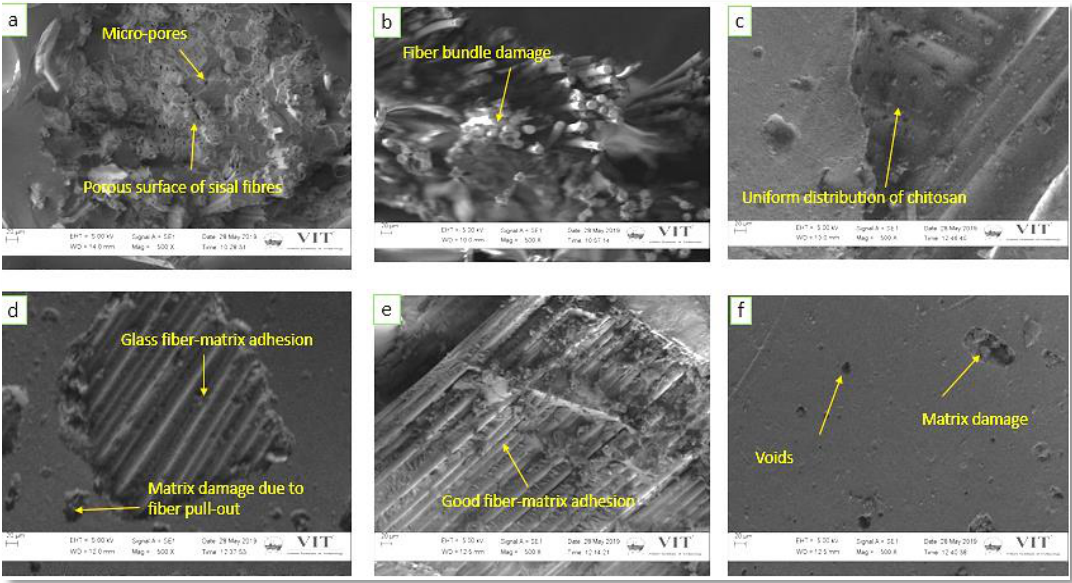
Figure 12. Compressive fractured surface of different composite used in this study: ( a ) A1, ( b ) A2, ( c ) A3, ( d ) A4, ( e ) A5, and ( f ) A6 composites.